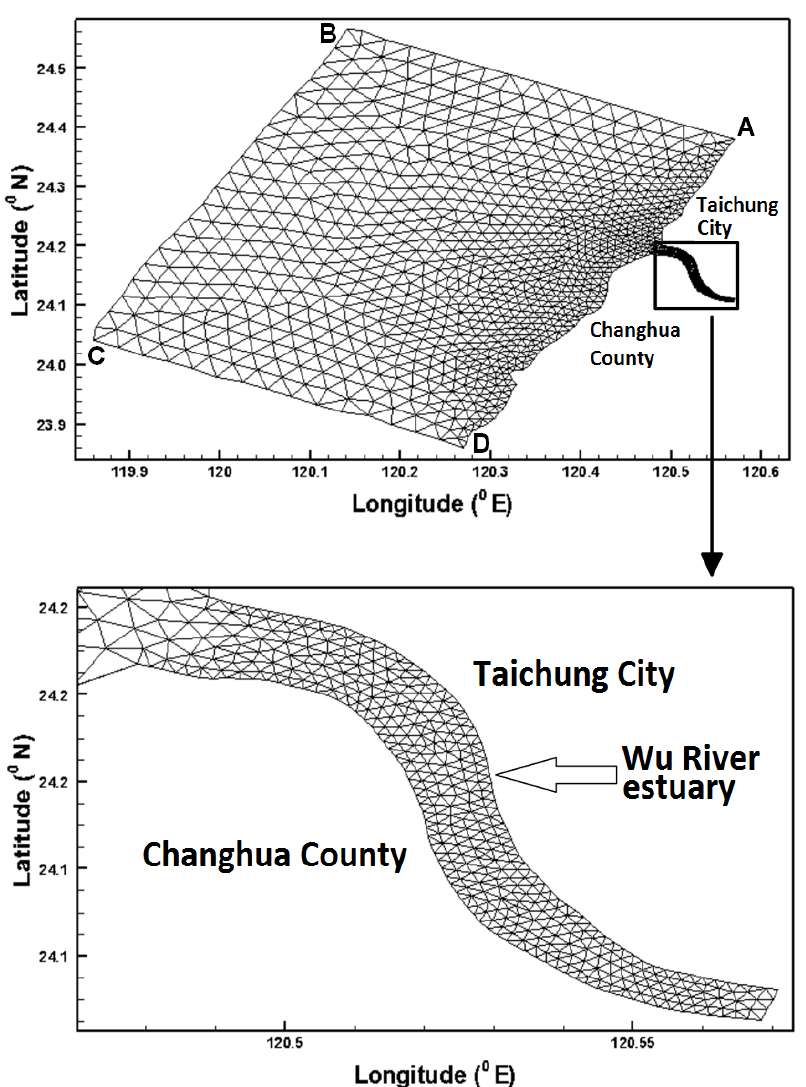
Figure 3. Unstructured grids in the modeling